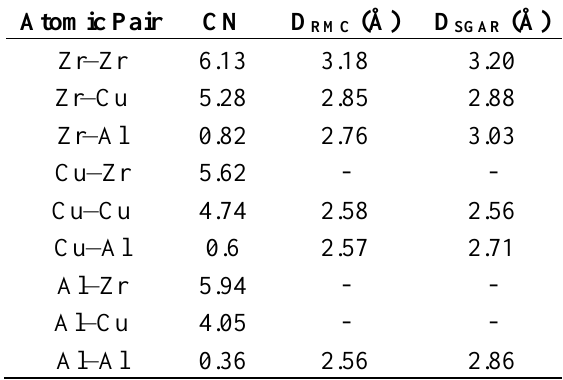
Table A1. Atomic structure information, including average CNs of M (M = Zr, Cu and Al) atoms obtained by RMC simulation; D RMC and D SGAR are the interatomic distances (atomic bonds) calculated from the RMC model and the sum of the Goldschmidt atomic radii (SGAR),